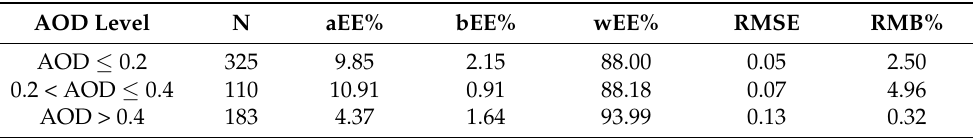
Table 2. Performance of the SEMARA AOD retrievals during low, moderate, and high aerosol loading conditions. N represents the total number of collocations; aEE%, bEE%, and wEE% represent the percentage of retrievals above, below, and within the expected error; RMSE represents the root mean squared error and RMB represents relative mean